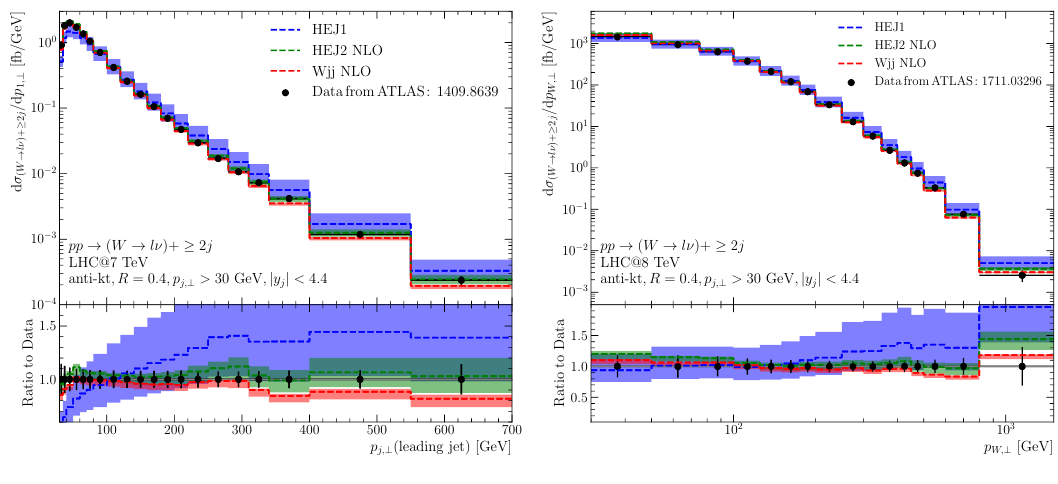
Figure 2: Predictions for pp → ( W → l ν )+ ≥ 2 j for the LHC, compared to ATLAS data at 7 TeV [ 16 ] and 8 TeV [ 17 ] . The content of the lines is discussed in the